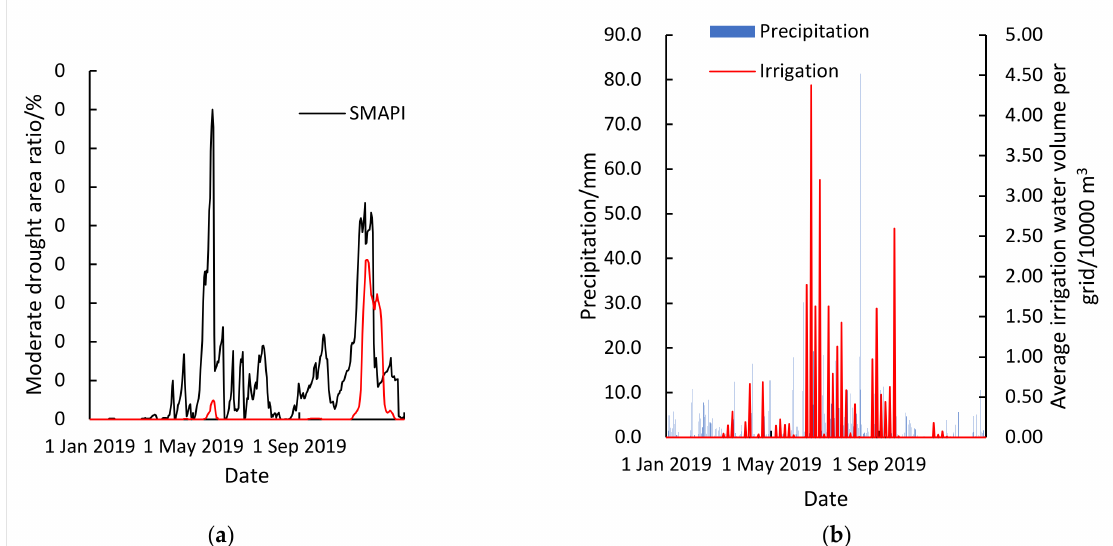
Figure 6. ( a ) Time courses of the area ratio of the moderate drought grade calculated by SMAPI and CWAPI; ( b ) Time courses of precipitation and irrigation of Jiangsu Province in